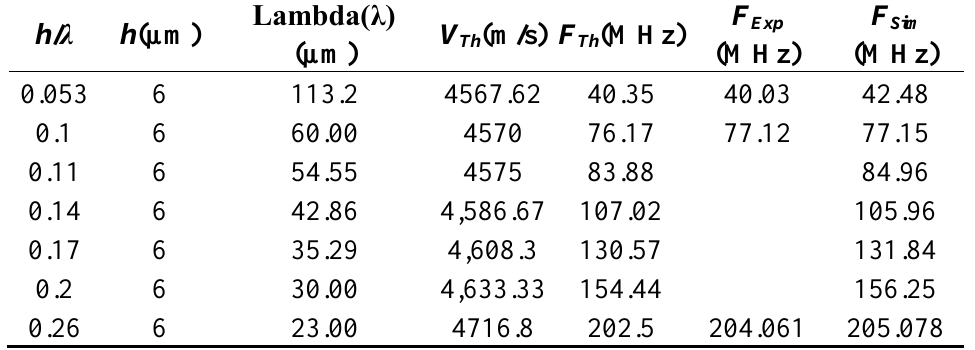
Table 3. Theoretical, simulation and experimental frequencyvalues for the different configurations.